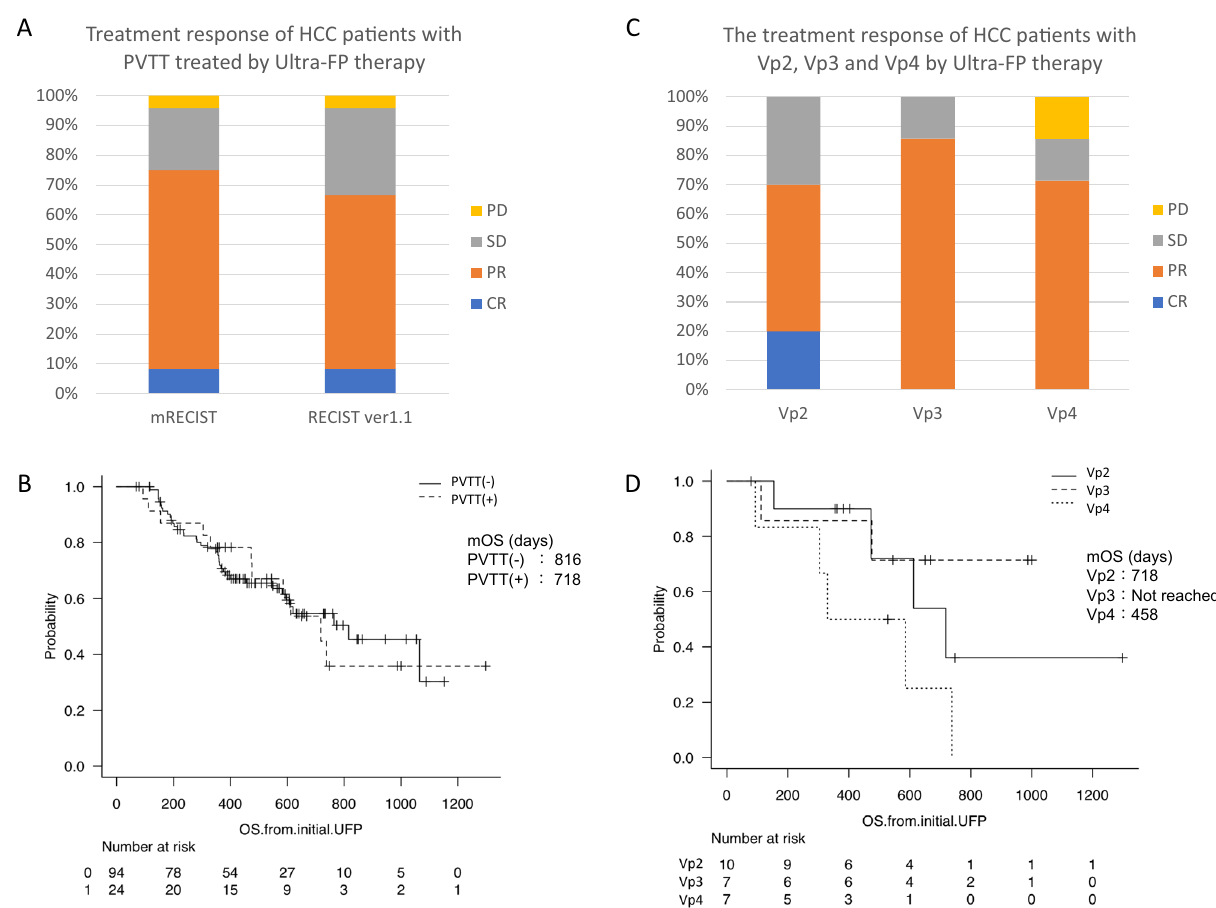
Figure 3. Treatment response and survival time depending on the existence of PVTT. Treatment response of HCC patients with portal vein tumor thrombosis (PVTT) treated by Ultra-FP therapy (modified Response Evaluation Criteria in Solid Tumors (RECIST) and RECIST ver 1.1) is shown ( A ). The survival curves of HCC patients with or without PVTT are shown ( B ). The treatment response of HCC patients with PVTT by Ultra-FP therapy CR/PR/SD/PD was 2/16/5/1 patients, respectively ( A ). The mOS of HCC patients with PVTT (−)/PVTT (+) was 816 days/718 days, respectively ( B ). The treatment response of HCC patients with portal vein invasion grade Vp2, Vp3 and Vp4 based on general rules for the clinical and pathological study of primary liver cancer by Ultra-FP therapy are shown ( C ). Vp4, main portal vein invasion; Vp3, first branch portal vein invasion; Vp2, second branch portal vein invasion. The treatment response of HCC patients with Vp2 by Ultra-FP therapy CR/ PR/SD/PD was 2/5/3/0 patients, respectively ( C ). The treatment response of HCC patients with Vp3 by Ultra-FP therapy CR/PR/SD/PD was 0/6/1/0 patients, respectively ( C ). The treatment response of HCC patients with Vp4 by Ultra-FP therapy CR/PR/SD/PD was 0/5/1/1 patients, respectively ( C ). The survival curves of HCC patients with Vp2/Vp3/Vp4 are shown ( D ). The mOS of HCC patients with Vp2/Vp3/Vp4 was 718/Not reached/458 days, respectively ( D